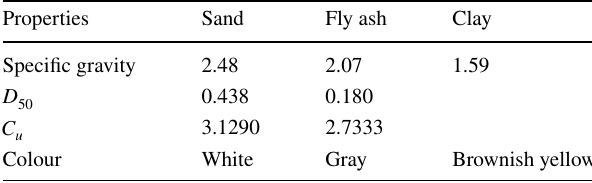
Table 1 Details of the material used for experiments Properties Sand Fly ash Clay Specific gravity